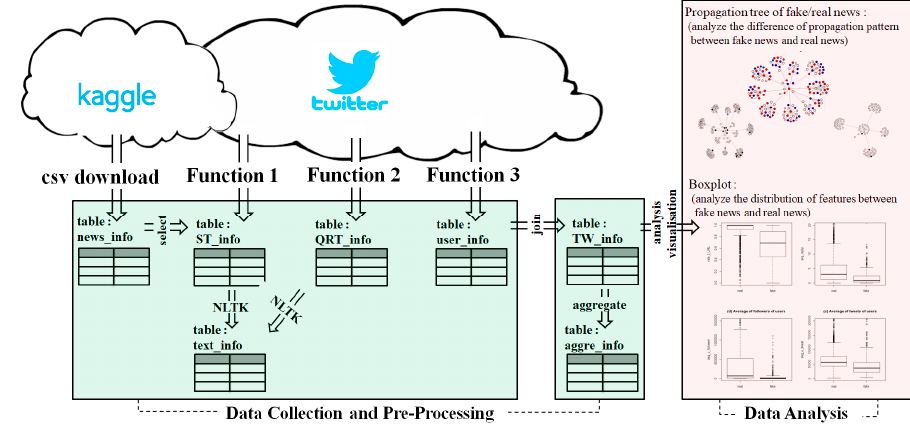
Figure 4. The overview of the fake news analysis model.